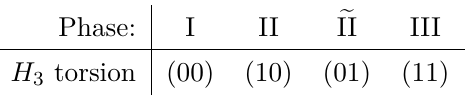
CFT in the language of the abstract SO